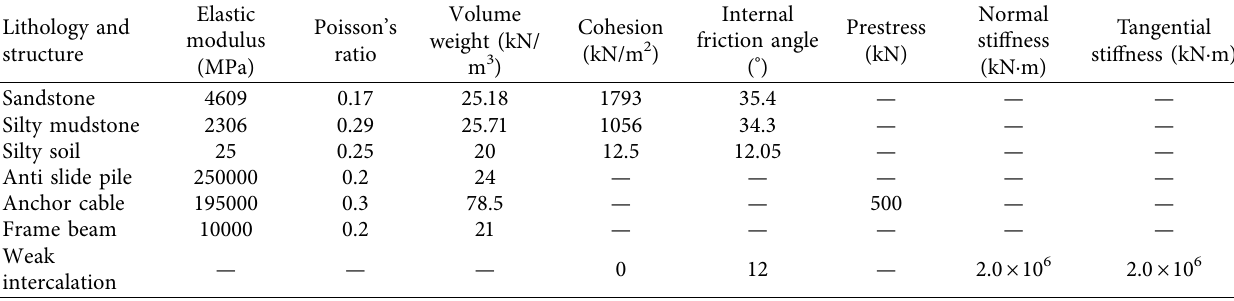
Table 1: Lithology and supporting structure calculation parameters.